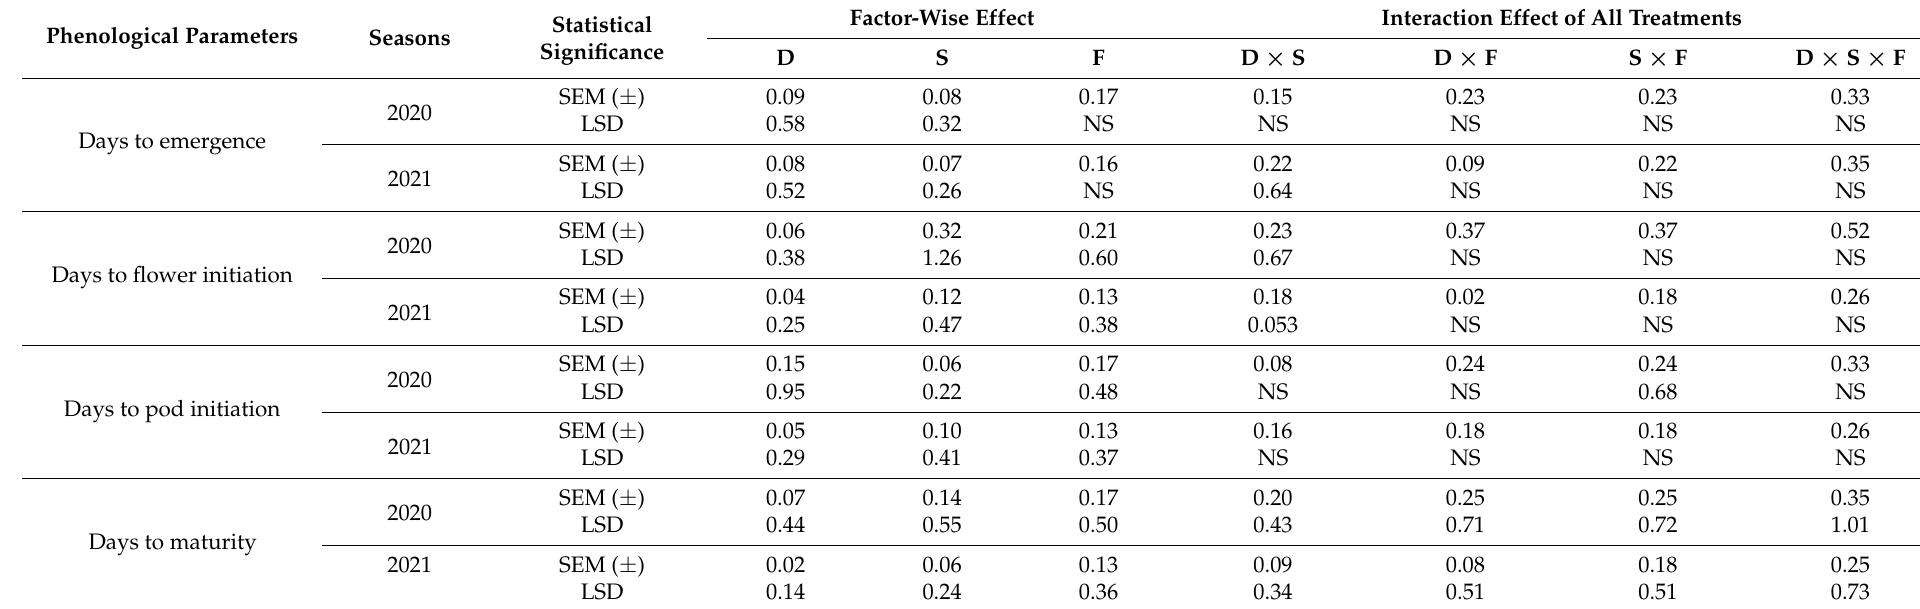
Table 5. Statistical significance and interaction effects of the date of sowing, soil application of Co, and foliar spray with K and B on the phenology of black gram during the spring-summer